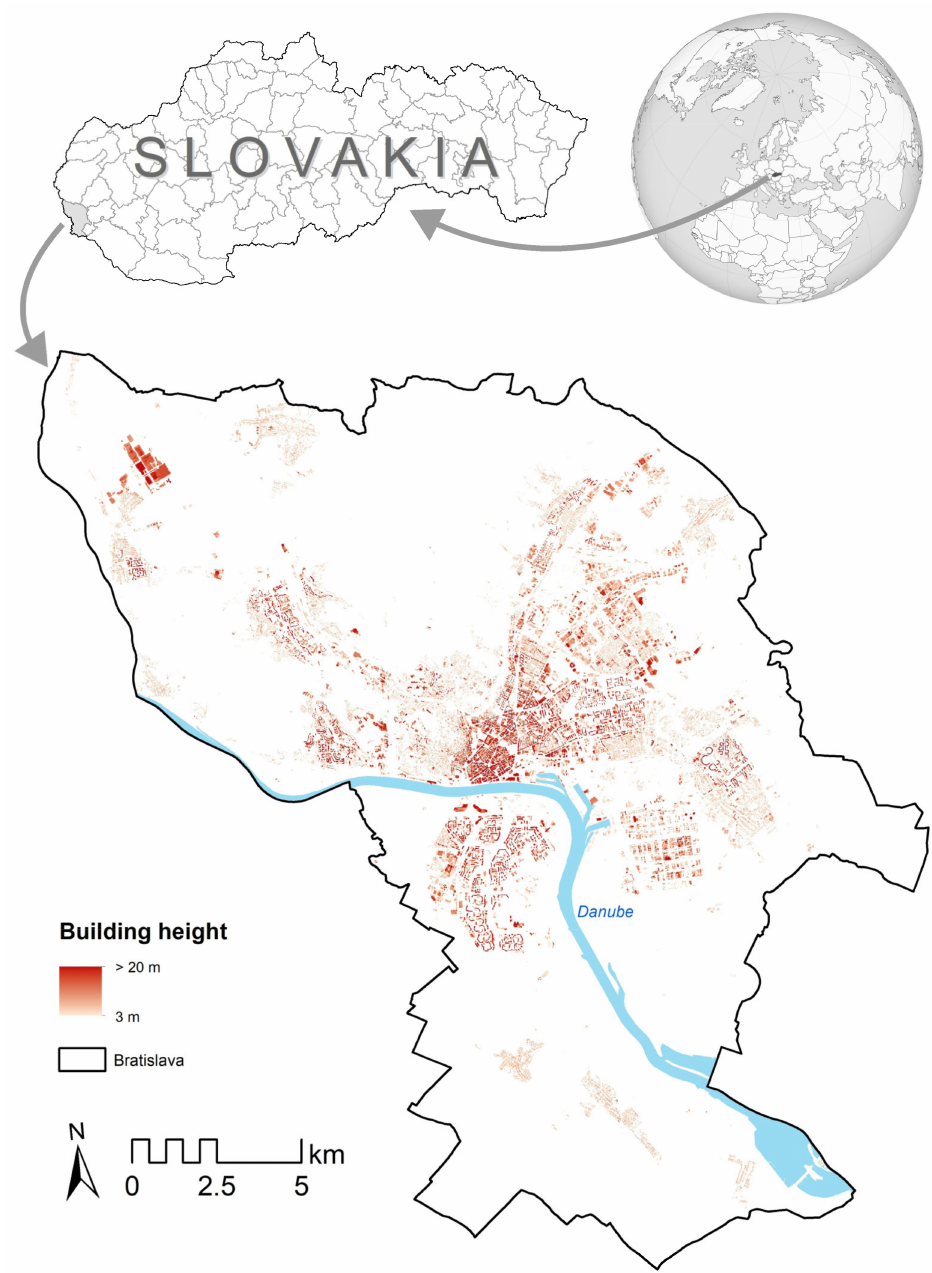
Figure 1. The BH2012 raster layer and the study